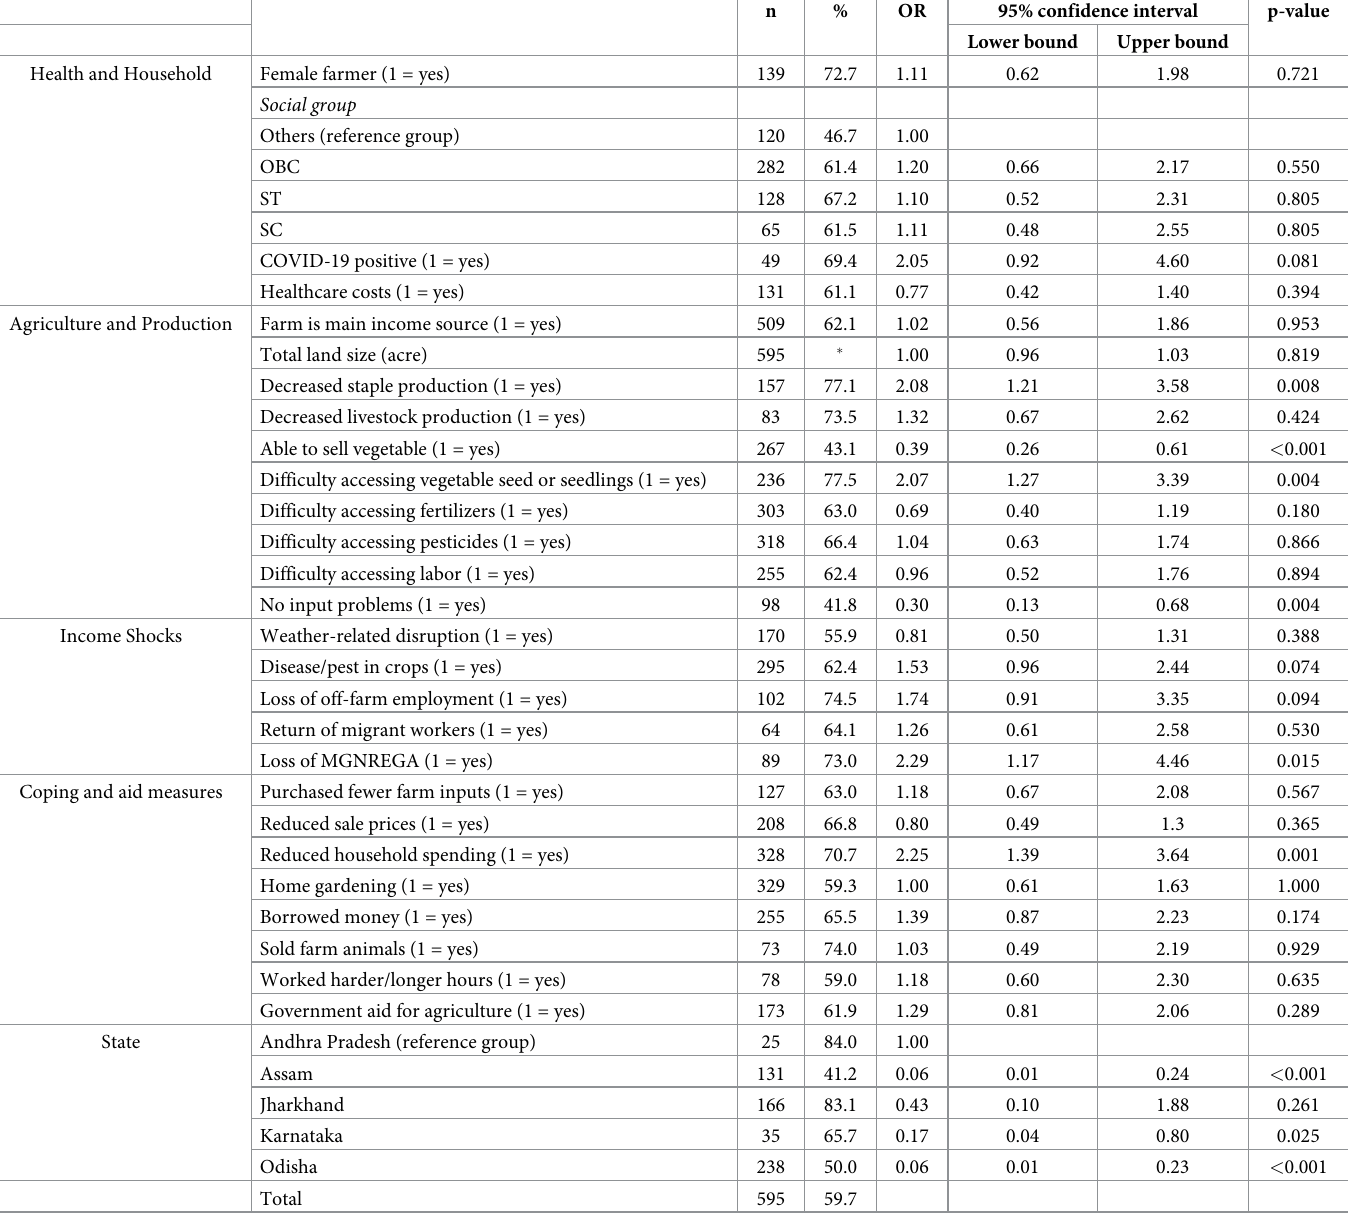
Table 3. Factors associated with decreased vegetable production